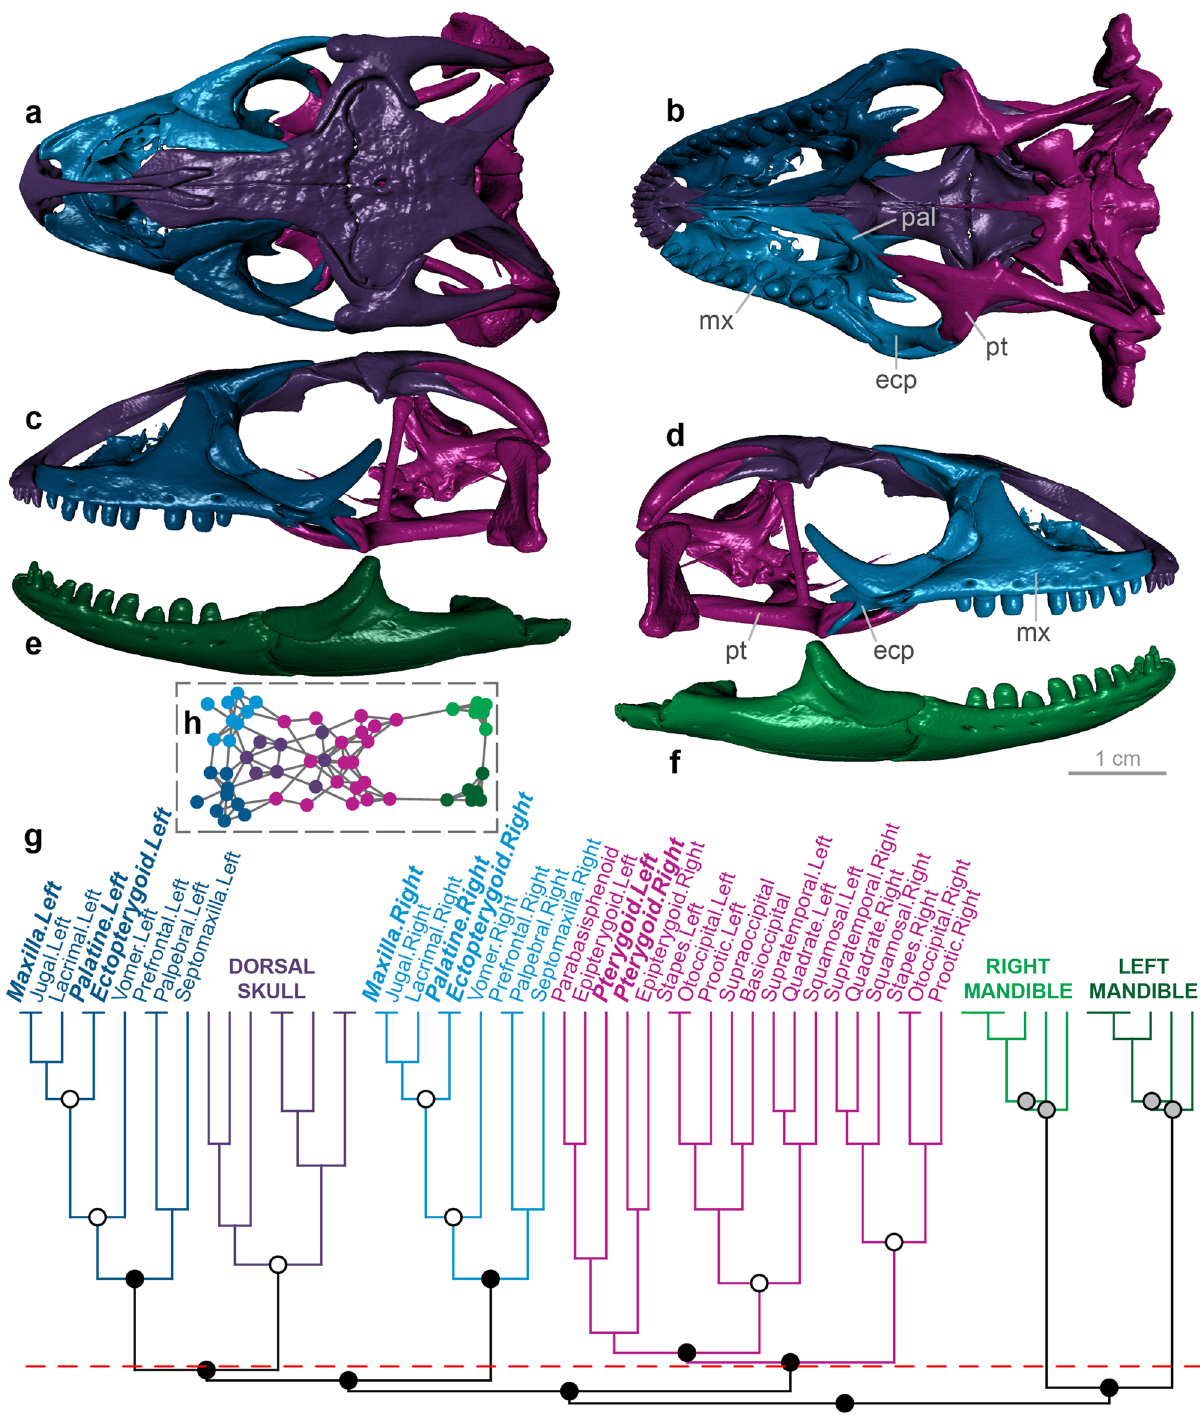
Figure 6. Skull modularity of non-snake lizards. Patterns of skull integration are highly variable among non- snake lizards, with skull regions often being separated across different modules within individual specimens. This is particularly true for the palatomaxillary elements (in italicized boldface), which are typically integrated to some extent with the snout, circumorbital elements, and braincase. ( a–f ) Representative pattern of non-snake lizard skull modularity, illustrated using Varanus exanthematicus (FMNH 58299) in ( a ) dorsal, ( b ) ventral, ( c ) left lateral, and ( d ) right lateral views of the skull, and ( e ) left lateral and ( f ) right lateral views of the mandible. ( g ) Network dendrogram of Varanus , reflecting this network architecture. Q-modules are indicated by Q max (represented by the red dotted line). S-modules are indicated by black (p < 0.001), grey (0.001 ≤ p < 0.01), or white (0.01 ≤ p < 0.05) circles. ( h ) Network representation of the skull of Varanus (see Supplementary Fig. S58 for labelled version). ecp ectopterygoid, mx maxilla, pal palatine, pt pterygoid. Dendrogram and network generated in R [v.4.0.3] 122 and RStudio [v.1.3.1093] 123 (see “Methods” section); specimen visualized in Dragonfly [v.4.1] 114